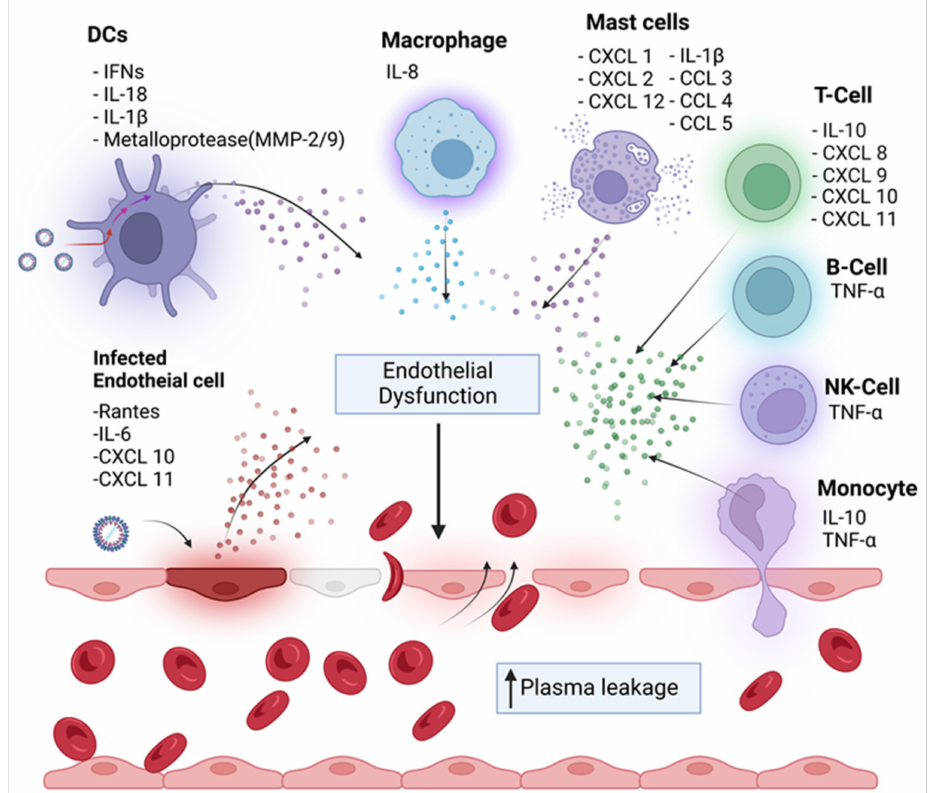
Figure 3. Cytokine storm seen in severe dengue infection. During a secondary heterologous infection, a robust immune response is generated, inducing the production of biological mediators including cytokine, chemokine, and other soluble factors from different immune cells as a consequence of com- plex interactions between the virus and host factors. These mediators promote vascular permeability resulting in an increase in plasma